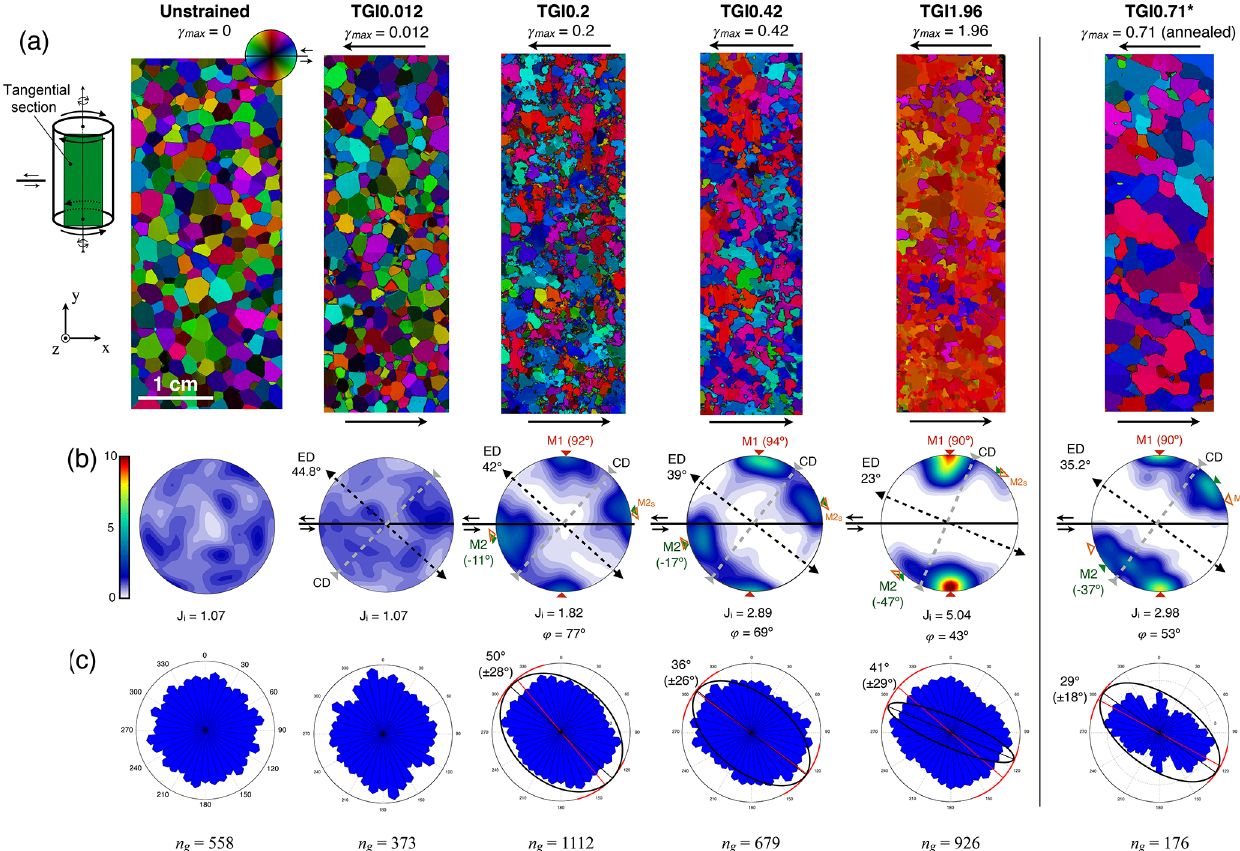
Figure 2. (a) AITA analyses of tangential sections for every sample showing the evolution of CPO and microstructure, with x parallel to the shear plane and y parallel to the torsion axis. The scheme on the upper right shows the geometrical relation between the tangential section and the retrieved cylindrical samples. Arrows indicate the shear directions. Color-coded c axis orientation is indicated by the color wheel. (b) Pole figures (equal area) showing the c axis orientations evolution with shear strain. Shear direction, direction of finite extension (ED) and compression direction (CD) are indicated with a black line, dotted black line and grey dashed line, respectively. Direction angles for the M1 and M2 sub-maxima are reported on the pole figures with red and green triangles, respectively, along with their angles with the ED direction. Theoretical perfectly symmetric M2 poles to M1 with ED direction (M2 S ) are represented in orange outline open triangles. J index (Bunge, 1982) and ϕ angle between M1 and M2 sub-maxima are indicated below for γ max ≥ 0 . 2. (c) Rose diagram of grain shape fabrics. Mean orientation is indicated as a red line and the 95% confidence interval as a red arc. Finite shear strain ellipses are plotted onto each rose diagram. The total number of grains segmented is reported as n g